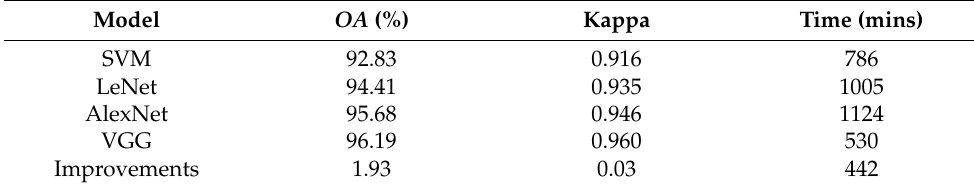
Table 7. A comparison of the four classification models for the classification accuracies and time complexities.